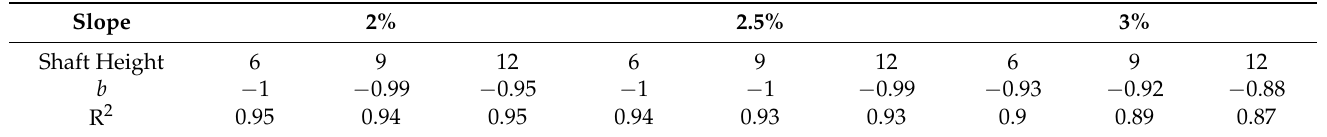
Table 2. Fi tt ing coe ffi cients of the dimensionless relation between inlet air velocity and fi re source location ( L f ≤ 330).